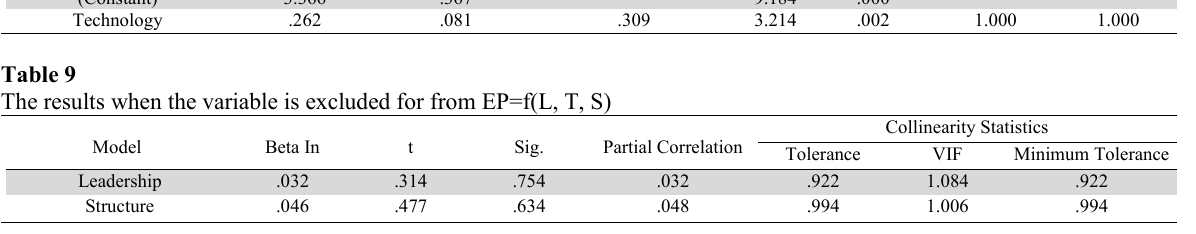
The results of regression analysis for EP = f(T) Unstandardized Coefficients Model